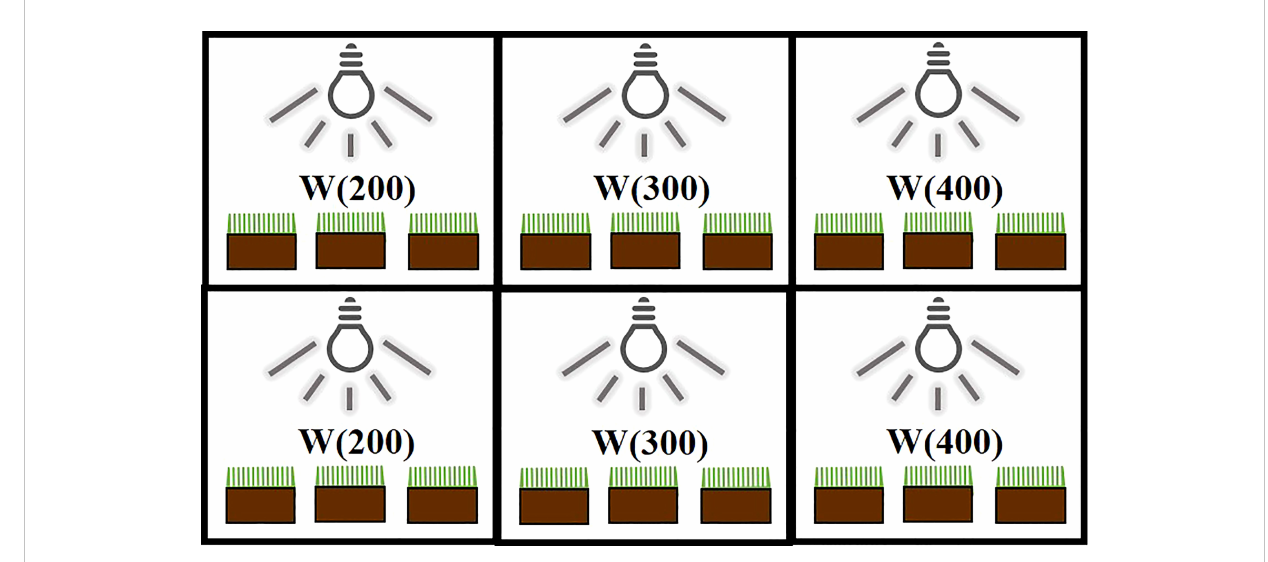
FIGURE 2 Schematic representation of the experiment 1. Cool white at 200 [W(200)], 300 [W(300)], and 400 [W(400)] m mol m − 2 s − 1 .